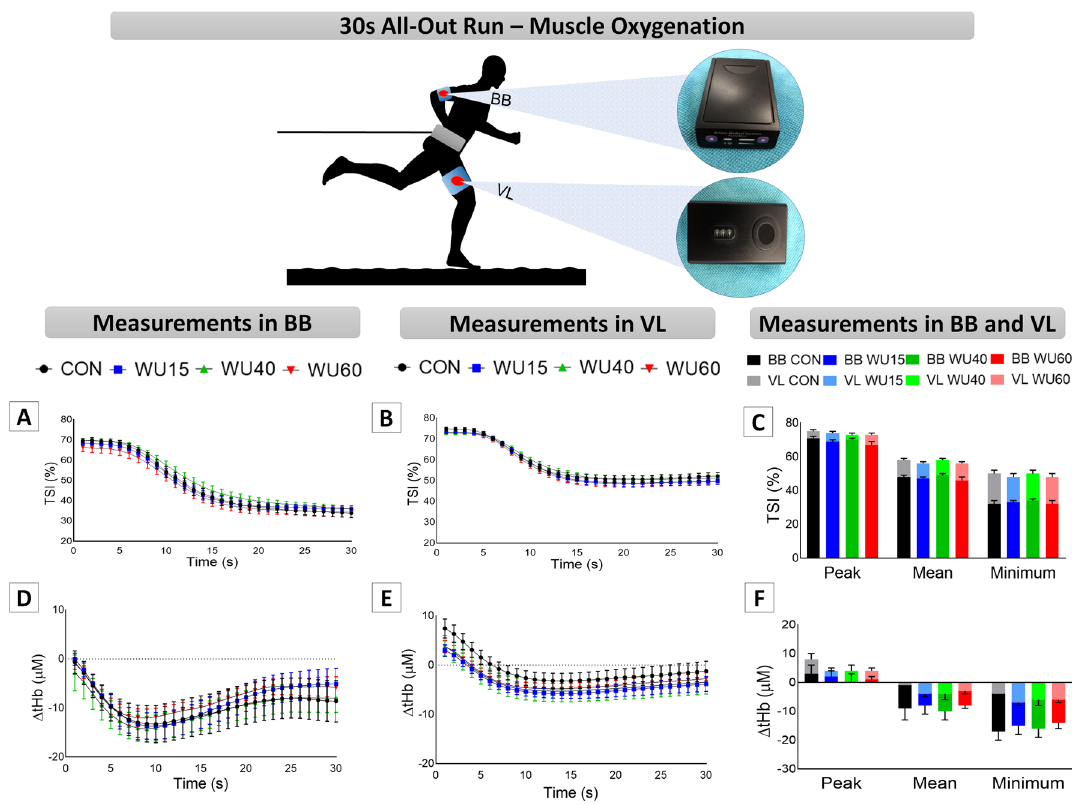
Figure 3. Results of tissue saturation indexes (TSI, Panels A–C ) and total hemoglobin ([tHb], Panels D–F ) in biceps brachii (BB) and vastus lateralis (VL) at each second during the 30 s all-out run on a non-motorized treadmill under control conditions (CON, black color) and after the IMW loads with 15% (WU15, blue color), 40% (WU40, green color) and 60% of MIP (WU60, red color), in line graphs. In bar graphs, the dark colors represent the BB, while the light colors correspond to the VL. MIP = maximum inspiratory